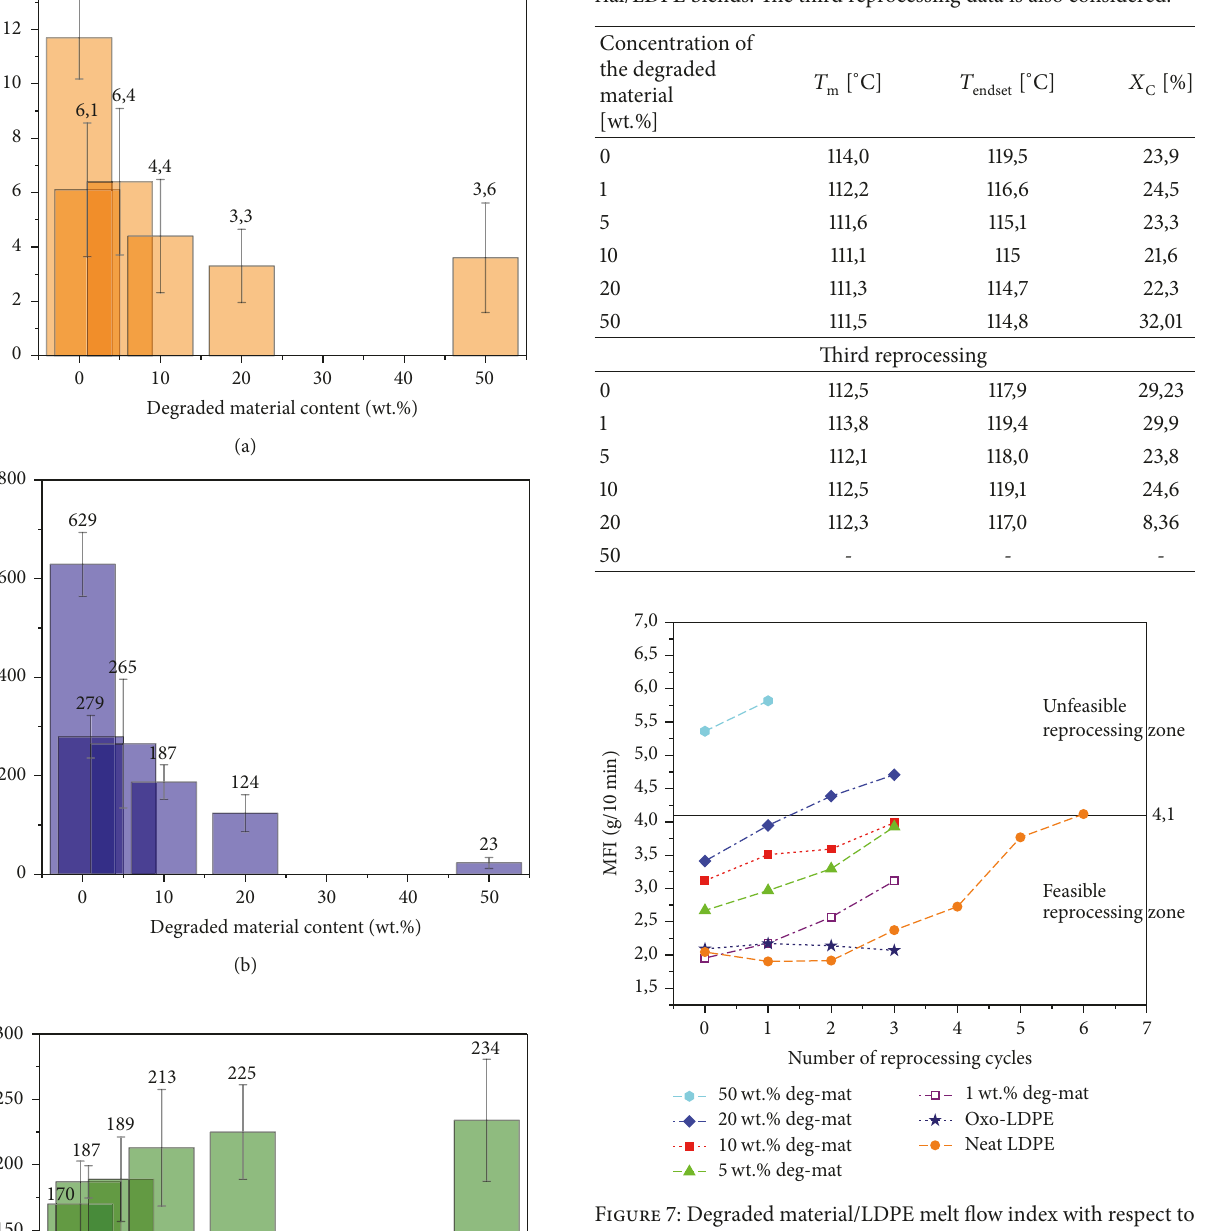
Figure 7: Degraded material/LDPE melt flow index with respect to the number of reprocessing cycles. The plot is divided into feasibility reprocessing